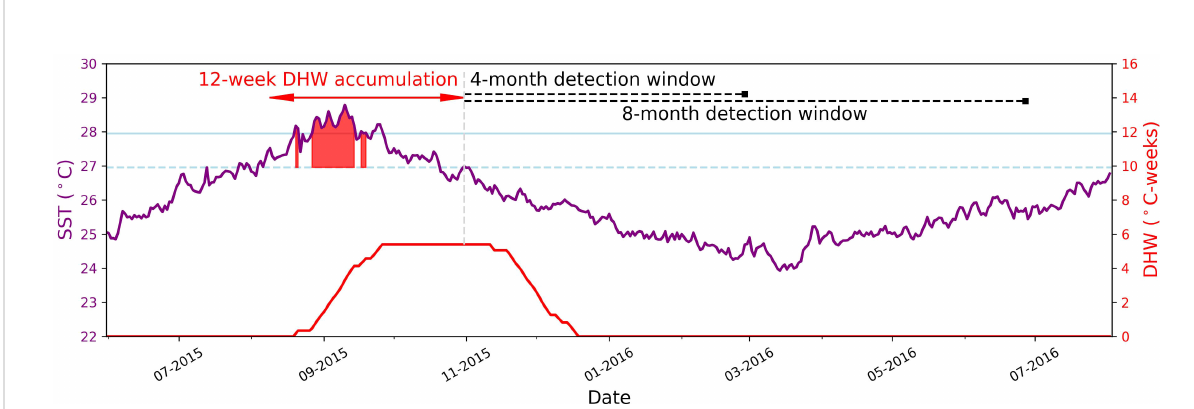
FIGURE 1 Sea-surface temperature (SST) time-series from the 5-km CoralTemp dataset for Lanikai on the north coast of Oahu, Hawaii (157.725°W, 21.375°N) for June 2015 to July 2016 (purple time-series). A Coral Bleaching HotSpot is a positive anomaly of SST above a locally-speci fi c climatological maximum temperature – the Maximum Monthly Mean (MMM; light blue dashed line), apparent from late-July to October 2015. HotSpot values of 1°C or greater (i.e., SST at or above MMM+1°C, light blue line) within the 12 weeks prior ( fi lled red polygons) are accumulated to give the Degree Heating Week (DHW; red time-series). The ‘ detection window ’ is de fi ned here as a period of time through which pixels identi fi ed as having been exposed to heat stress should continue to be counted as part of a basin-scale event (shown for 4- and 8-month periods from 01 November